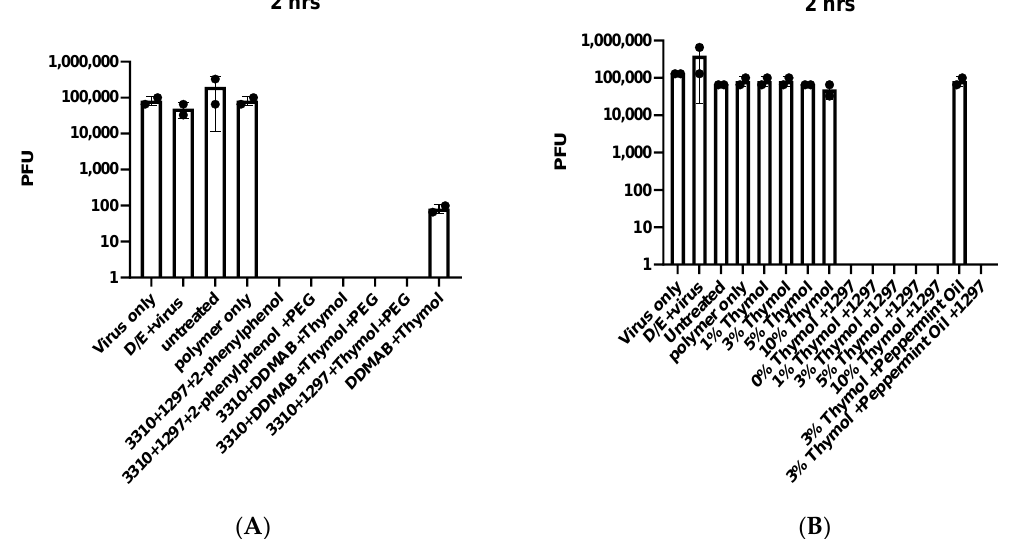
Figure 1. Screen for inactivation of SARS-CoV-2 by surgical masks infused with quaternary ammonium compounds. n = 2, separate experiments in ( A , B ). Error bars show standard deviation. Y axis shows total PFU detected in each sample.